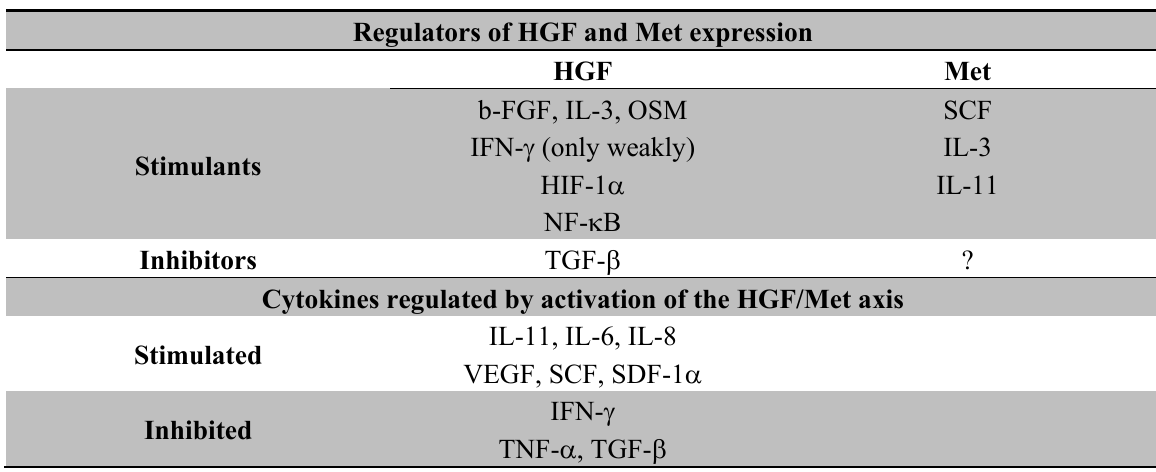
Table 2. Regulation of HGF / Met expression, and cytokines regulated by